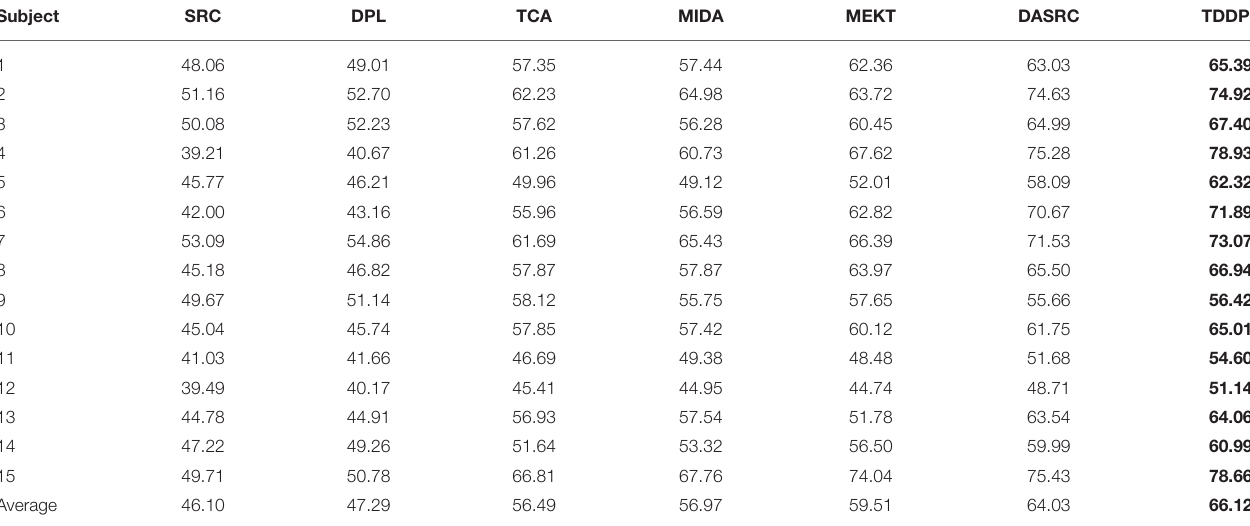
TABLE 5 | Average classification accuracies on session 1 of SEED IV dataset in the m → o